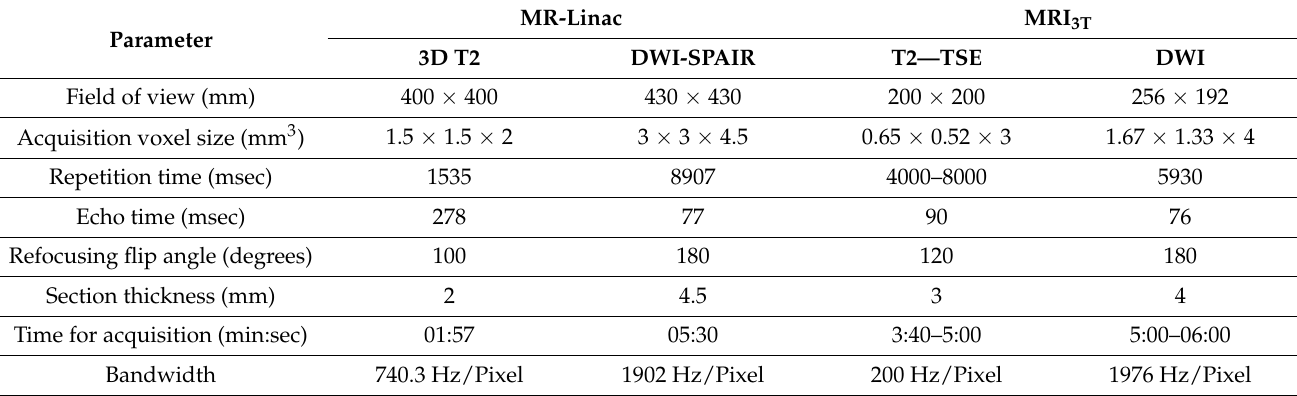
Table 1. Magnetic Resonance Acquisition Parameters of T2-weighted images and DWI for MRL and MRI